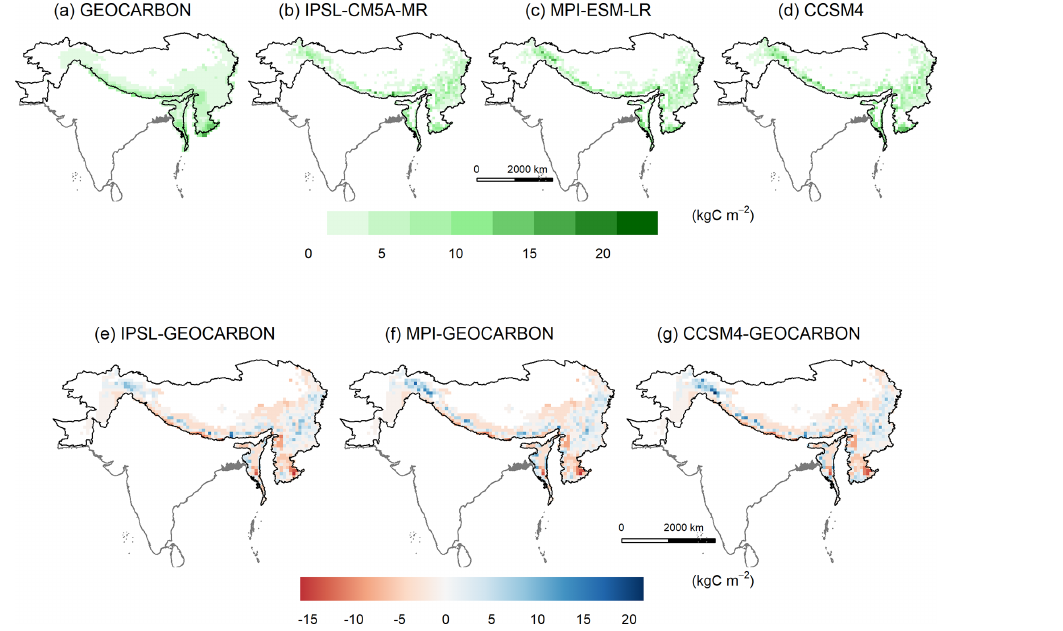
Figure 2. The distribution of VegC as simulated by (a) GEOCARBON, (b) IPSL-CM5A-MR, (c) MPI-ESM-LR and (d) CCSM4, and (e–g) their respective differences with the GEOCARBON dataset for the HKH region.